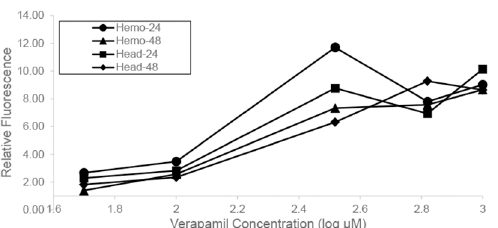
Fig 4. Rhodamine B fluorescence of head and hemolymph tissues. Mean fluorescence relative to no- verapamil controls (24 and 48 h post feeding) at a series of verapamil concentrations.